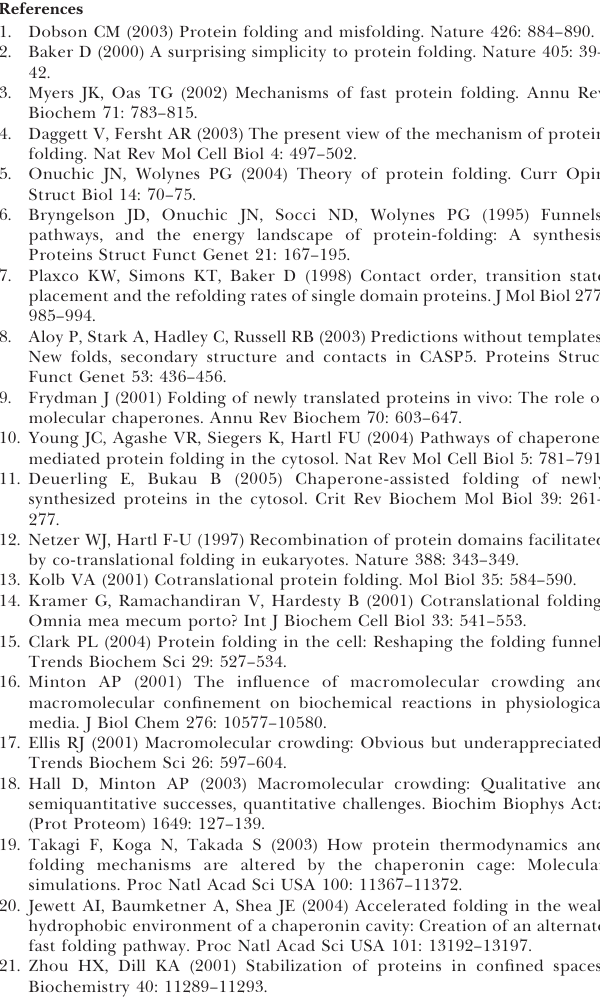
of CI2 in the presence (filled symbols) and absence (open symbols) of the ribosome with V 1 ¼ 0.125 kcal/mol; error bars indicate the standard deviation of values obtained from 30 independent trajectories. (D) Same as (C), but with V 1 ¼ 0.25 kcal/mol. (E) Same Figure S14. Correspondence between P fold and the Free Energy G for CI2 and Barnase (A) Plot showing the free energy, G, and P fold as a function of Q for CI2; error bars for the P fold plot represent the standard deviation of values calculated for 500 sampled structures in each Q bin. (B) Same as (A), but for barnase. Found at DOI: 10.1371/journal.pcbi.0020098.sg014 (54 KB PPT). Text S1. Discussion of Limitations of Go-Type Models for Protein Folding Found at DOI: 10.1371/journal.pcbi.0020098.sd001 (92 KB